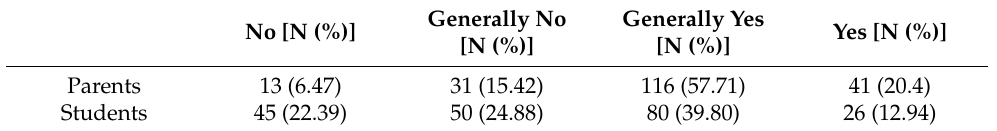
Table 9. Physical distancing in public places.